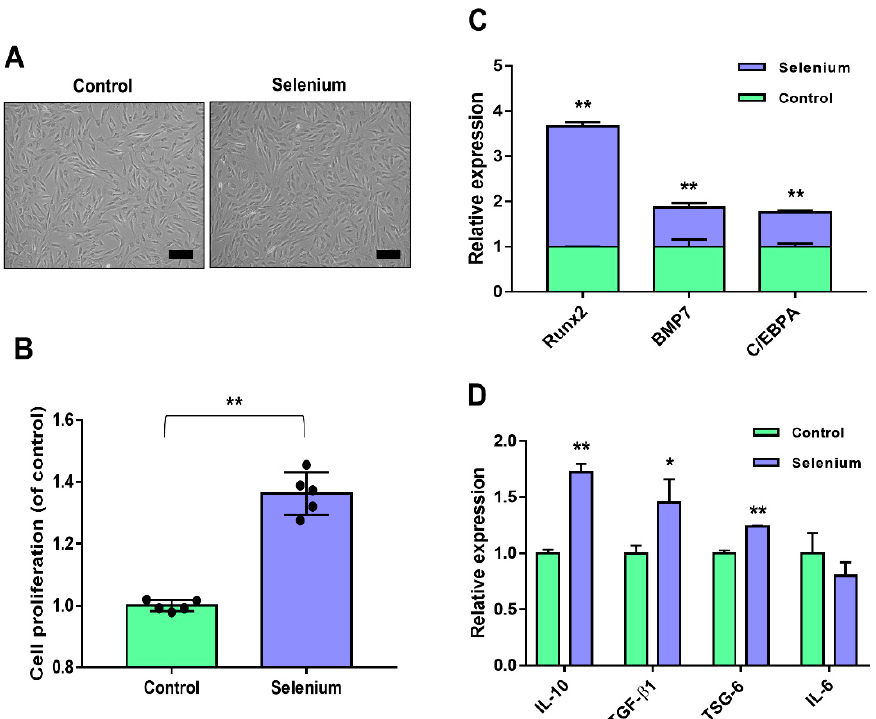
Figure 1. Effects of selenium on the stemness of AdMSCs. ( A ) A picture of the cell morphology was taken before and after treatment with 5 ng/mL selenium (100 × magnification, scale bar = 200 µ m). ( B ) Proliferation rates of AdMSCs after exposure to selenium were determined using a WST-based assay. ( C ) Relative mRNA levels of key genes for multi-lineage differentiation were analyzed by real-time PCR. ( D ) Relative mRNA levels of inflammation-related genes were evaluated by real-time PCR. Data are expressed as the mean ± SD of three independent experiments. * Significant difference from control, p < 0.05. ** Significant difference from control, p < 0.01.